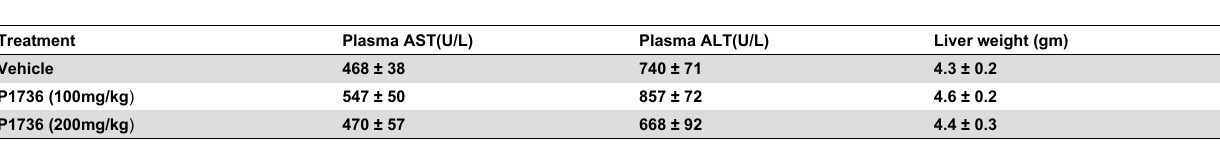
Table 3. Effect of P1736 on Liver safety parameters in ob/ob mice.